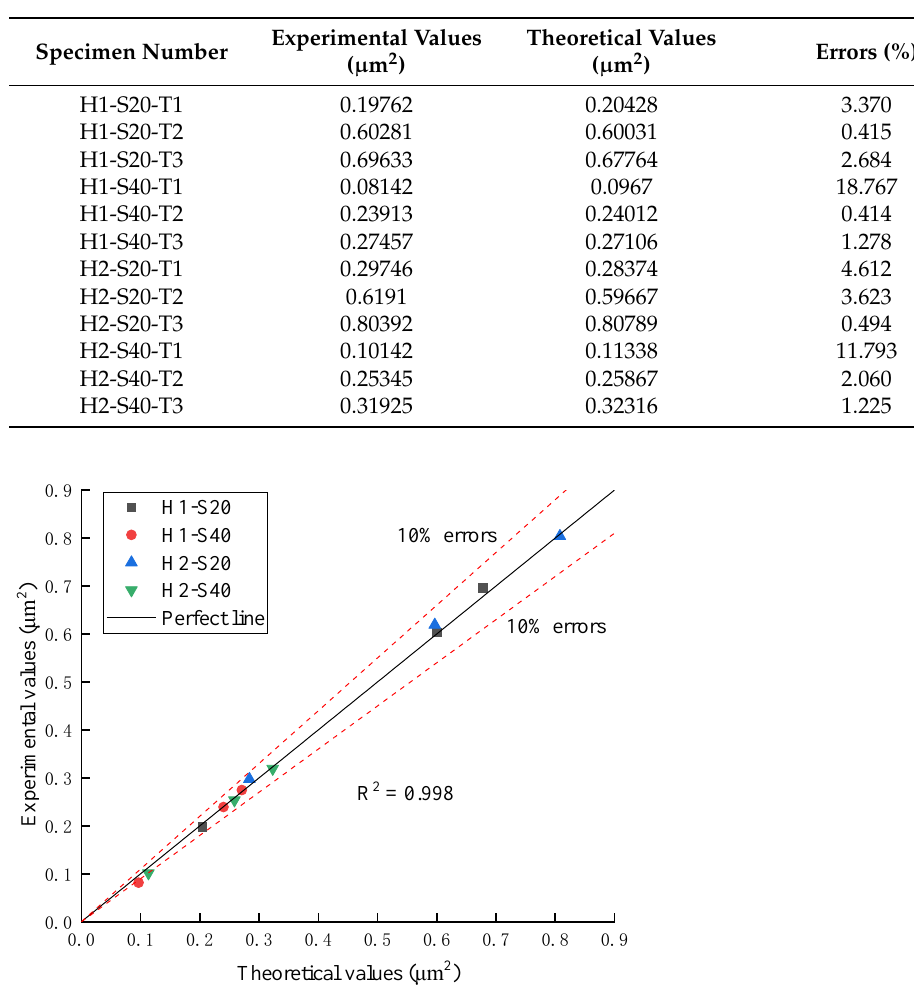
Table 6. Comparison between the experimental and theoretical values.